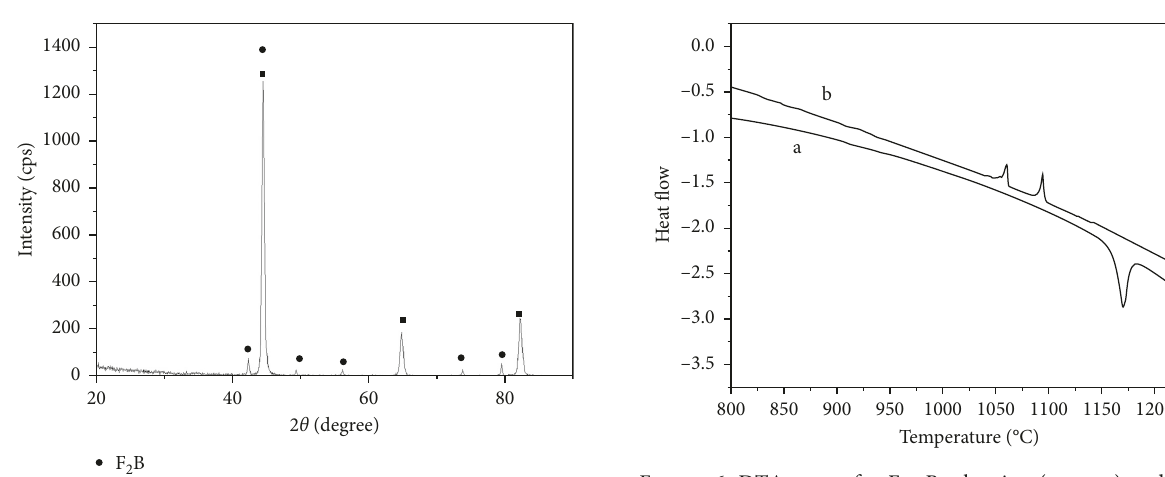
83 B 17 heating (curve a) and cooling 1 . min · −